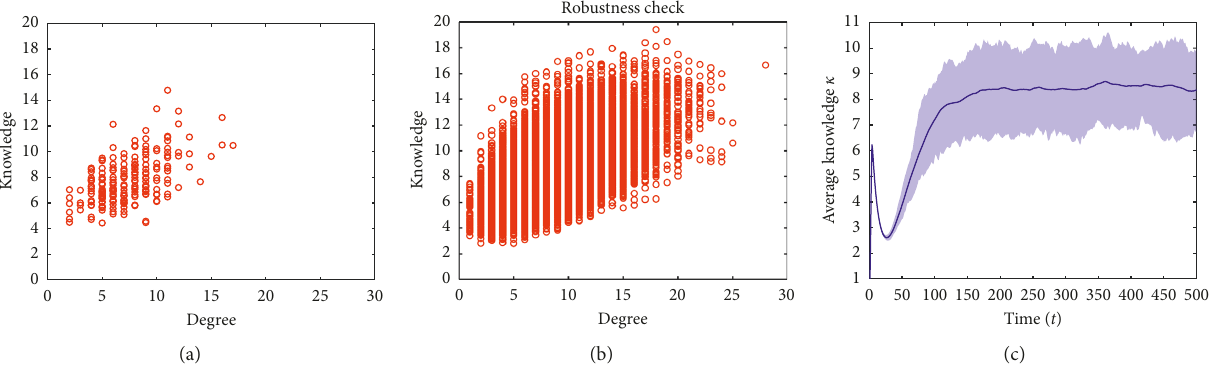
Figure 2: Evolution result when the initial R&D network structure is a WS small-world network ( p � 0 . 1).